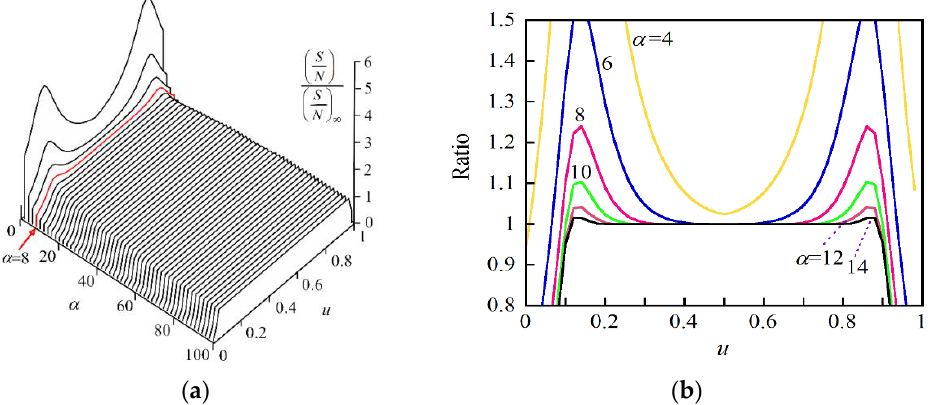
Figure 11. ( a ) Ratio of S/N to (S/N) ∞ as functions of α and u . ( b ) Ratio of S/N to (S/N) ∞ as a function of u when α was changed from 4 to 14 in steps of 2. α = βτ e / δχ e , where β is the sweep rate of the angular frequency of the tunable laser output, τ e is the round-trip time from the origin at z = 0 to the output end of the fiber under test at z = z e and thus u = z / z e . δχ e is the spectral half width at 1/ e maximum of the Gaussian spectrum G ( χ ).